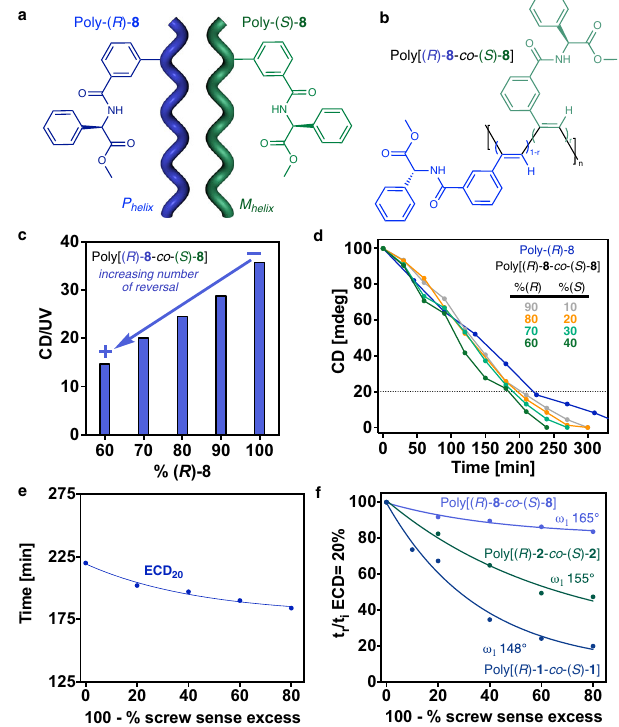
Fig.7|Roleofreversalsonstretchedc-tpolymers.a Chemicalstructureandhelix sense representation of poly-( R ) − 8 and poly-( S ) − 8 . b Chemical structure of the copolymer poly[( R ) − 8 -co-( S ) − 8 ]. c Variation of the CD/UV signal (CD@428nm)